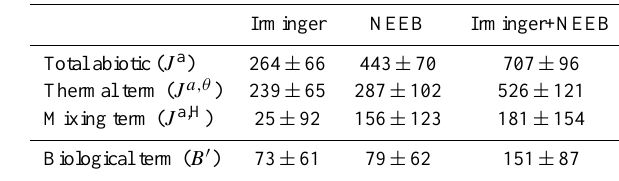
Table 4. Abiotic air–sea oxygen flux partitioning. Fluxes are in kmol s − 1 , positive values corresponding to ocean ingassing. For comparison, we indicated the biological source/sink term B 0